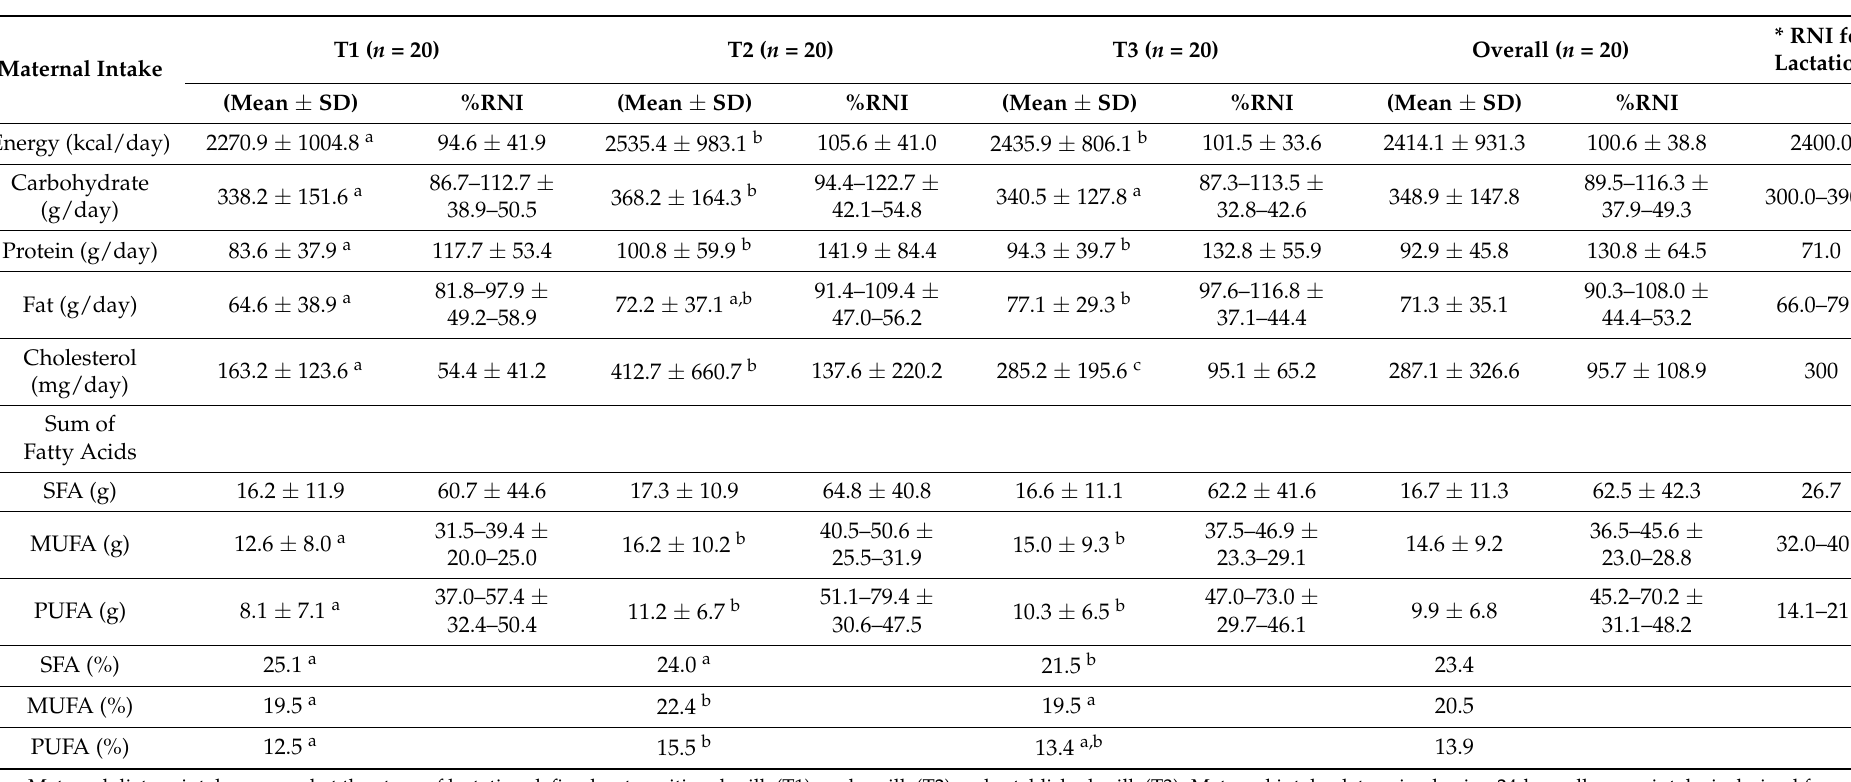
Table 2. Maternal dietary intake at three consecutive assessments (T1, T2, T3) (Mean ± SD) and % meeting daily recommendation (*